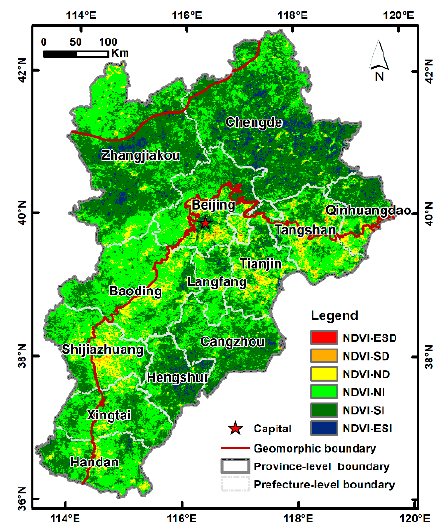
Figure 3. Spatial distribution of the NDVI trends. NDVI-ESD represents an extremely significant decrease, NDVI-SD represents a significant decrease, NDVI-ND represents a nonsignificant decrease, NDVI-NI represents a nonsignificant increase, NDVI-SI represents a significant increase, and NDVI-ESI represents an extremely significant increase.